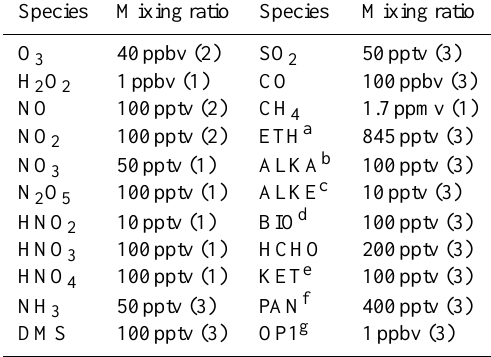
Table 5. Initial gas mixing ratios for the HaRP case. The form of the vertical profile is indicated in parentheses as 1 for homogeneous, 2 for stratospheric, and 3 for boundary layer profile.